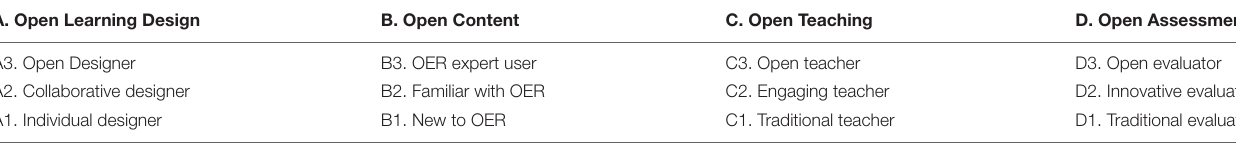
TABLE 2 | Summary table to situate the scholar’s Open Educational Practices.